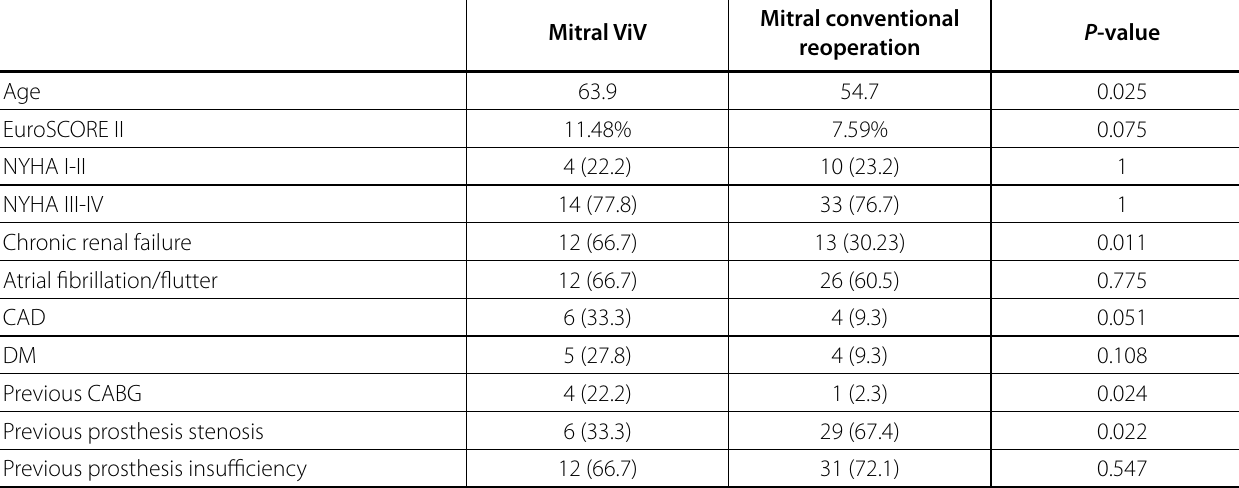
Table 2 . Preoperative characteristics comparison between 18 mitral ViV patients and 43 conventional mitral